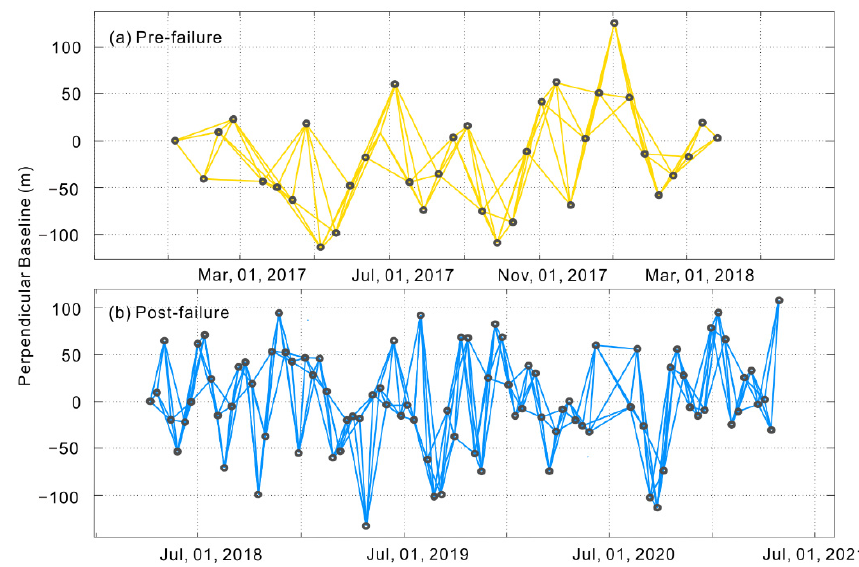
Figure 4. Spatial and temporal baselines of the Sentinel-1 data used in this study: ( a ) pre-failure spatial and temporal baselines, ( b ) post-failure spatial and temporal baselines.